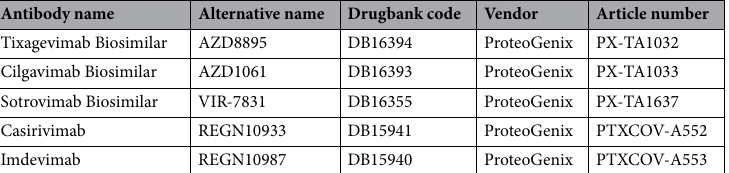
Table 2. Summary of antibody reagents used in this